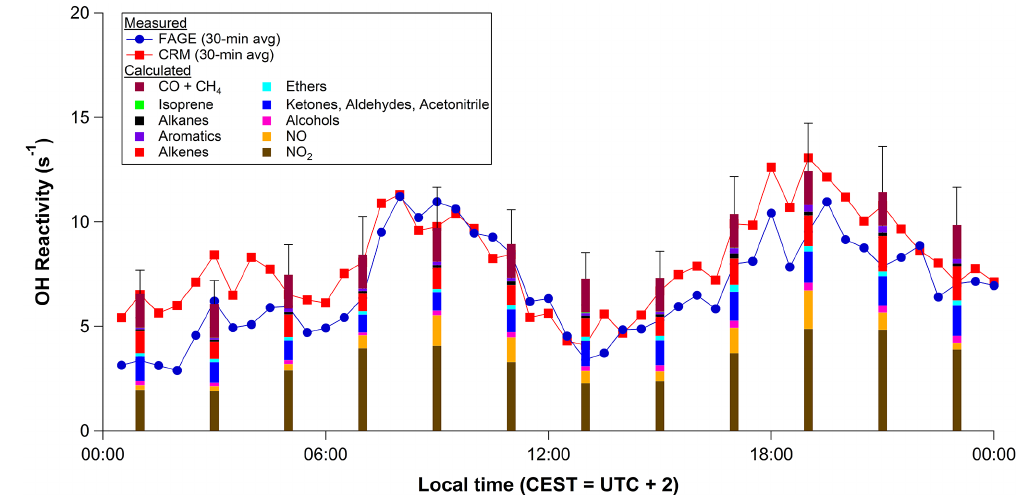
Figure 8. Diel averages from 10 to 16 October of the measured (lines and markers, 30min averages) and calculated (bars, 2h averages) for the time periods during which OH reactivity, VOCs, and NO x were measured concurrently. Error bars represent 1 σ